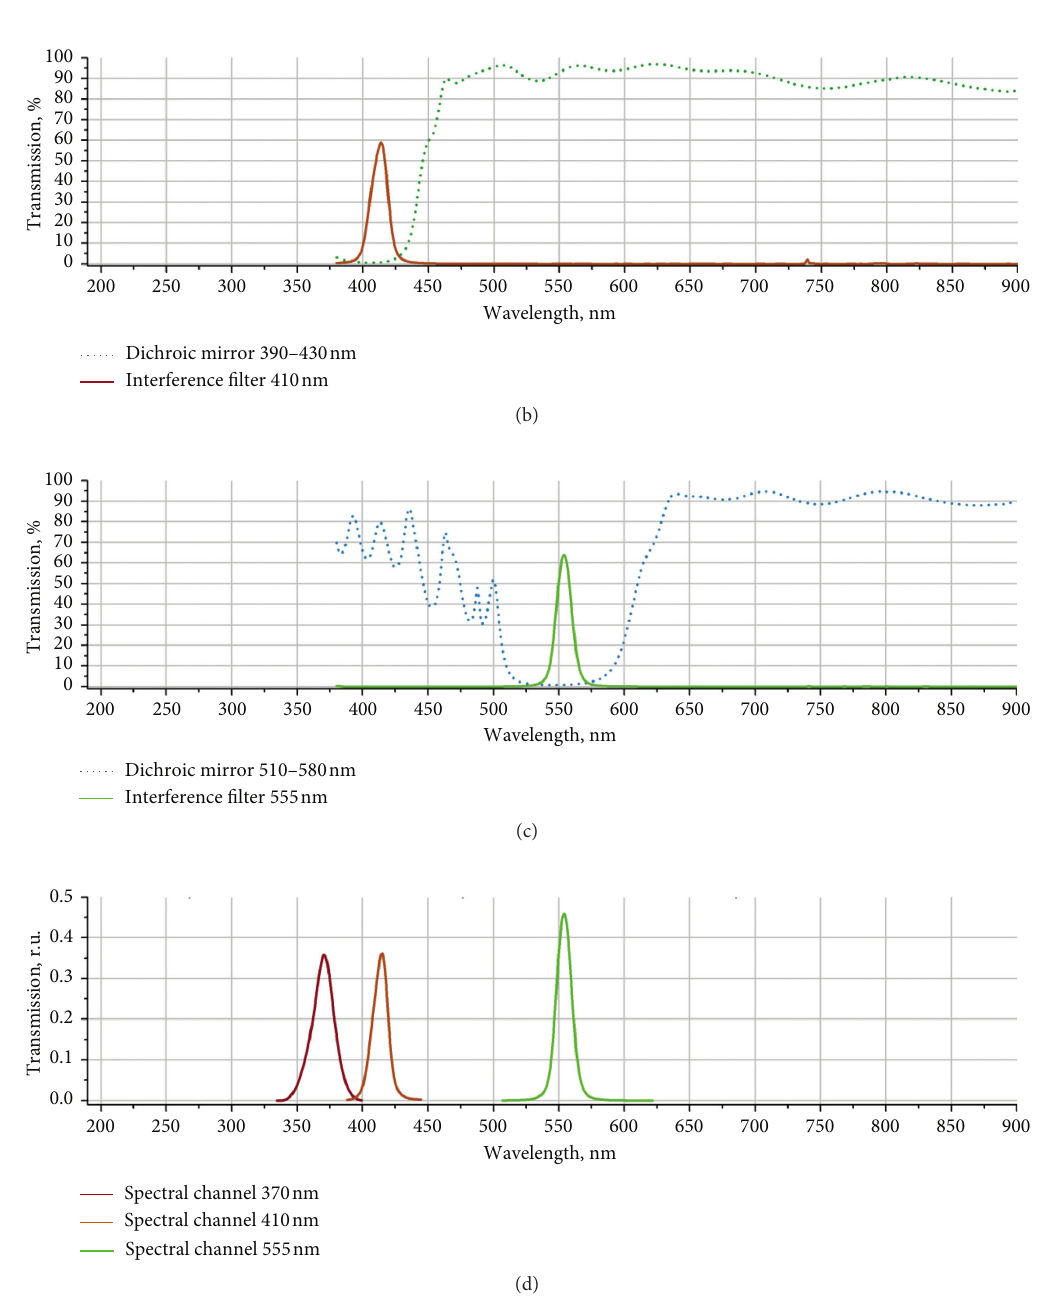
Figure 3: Characteristics of the individual dichroic mirrors and spectral filters and the resulting characteristics for spectral channels 370nm, 410nm, and 555nm of the optical units